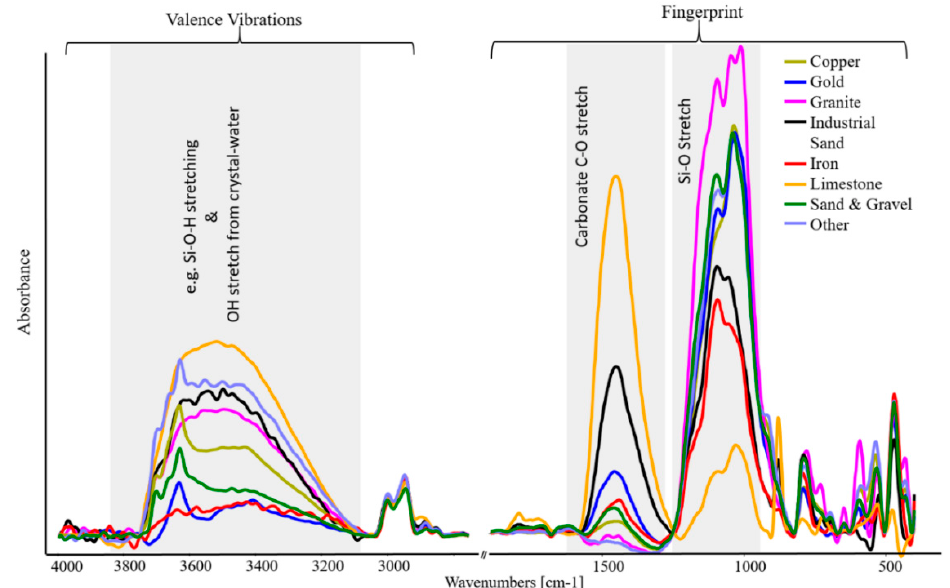
Figure A1. Incidence of mineral phases distributed in the samples collected in different mining operations.